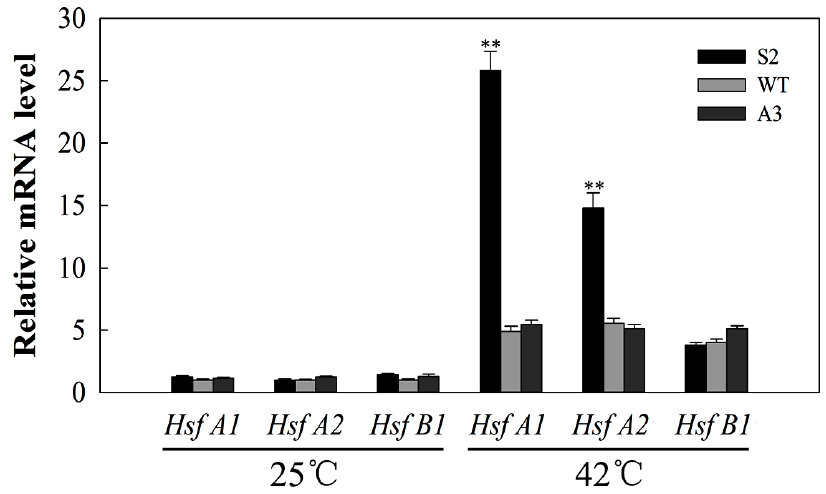
Figure 10. Quantitative PCR analysis of HsfA1 , HsfA2 , and HsfB1 expression before and after heat stress. Six-week-old WT and transgenic plants were used for treatment under 42 °C for 12 h. The mean values ± SD of at least three replicates are presented, and ** p < 0.01 indicate significant differences compared with the control.